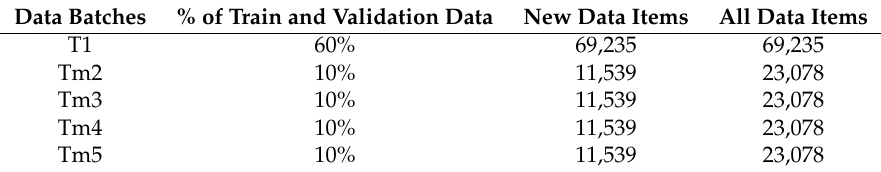
Table 5. Partitioning of dataset (Strategy III).